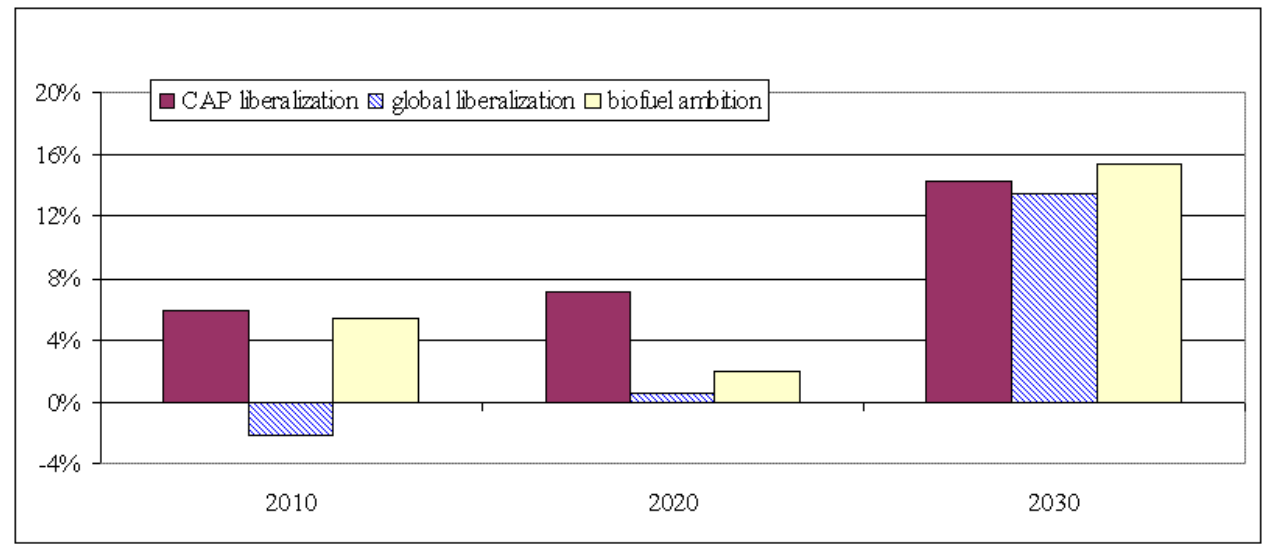
Fig. 6 . Difference in cumulative land use-related CO (CAP) Liberalization, the Global Liberalization option, and the Biofuel Ambition option compared to the